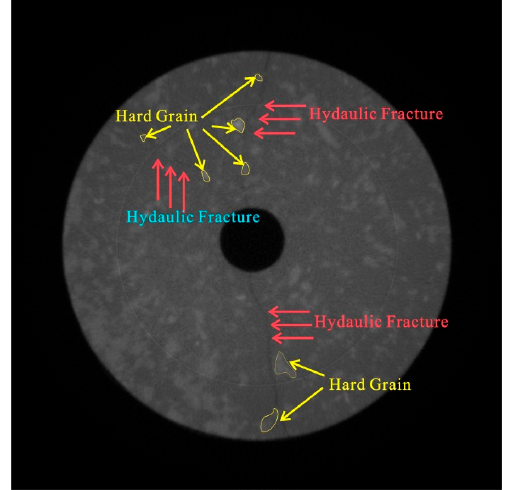
Figure 10. Typical CT image of fractured granite core.